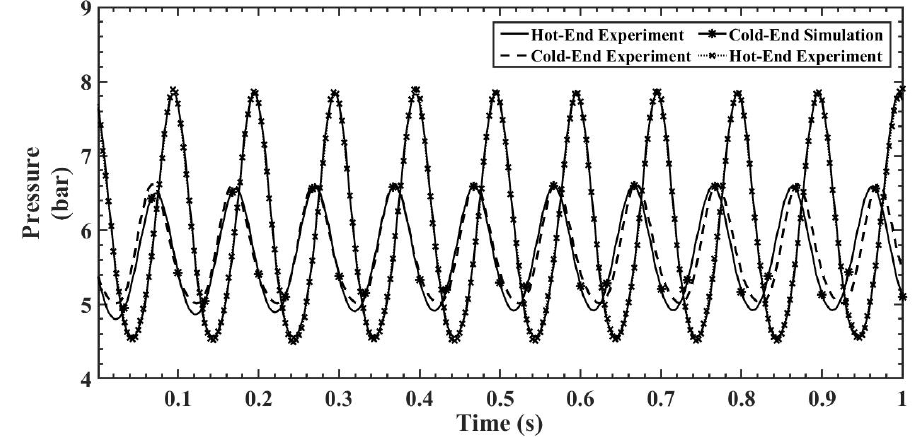
Figure 13. Hot- and cold-section pressure characteristics of a 300 mesh regenerator at 600 RPM.